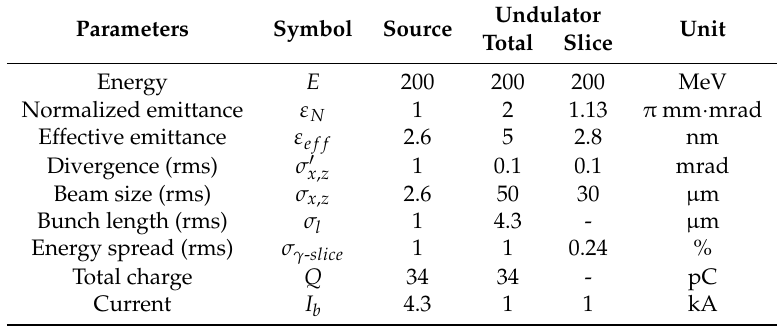
Table 3. Baseline reference case parameters at the generation point in the gas jet and at the